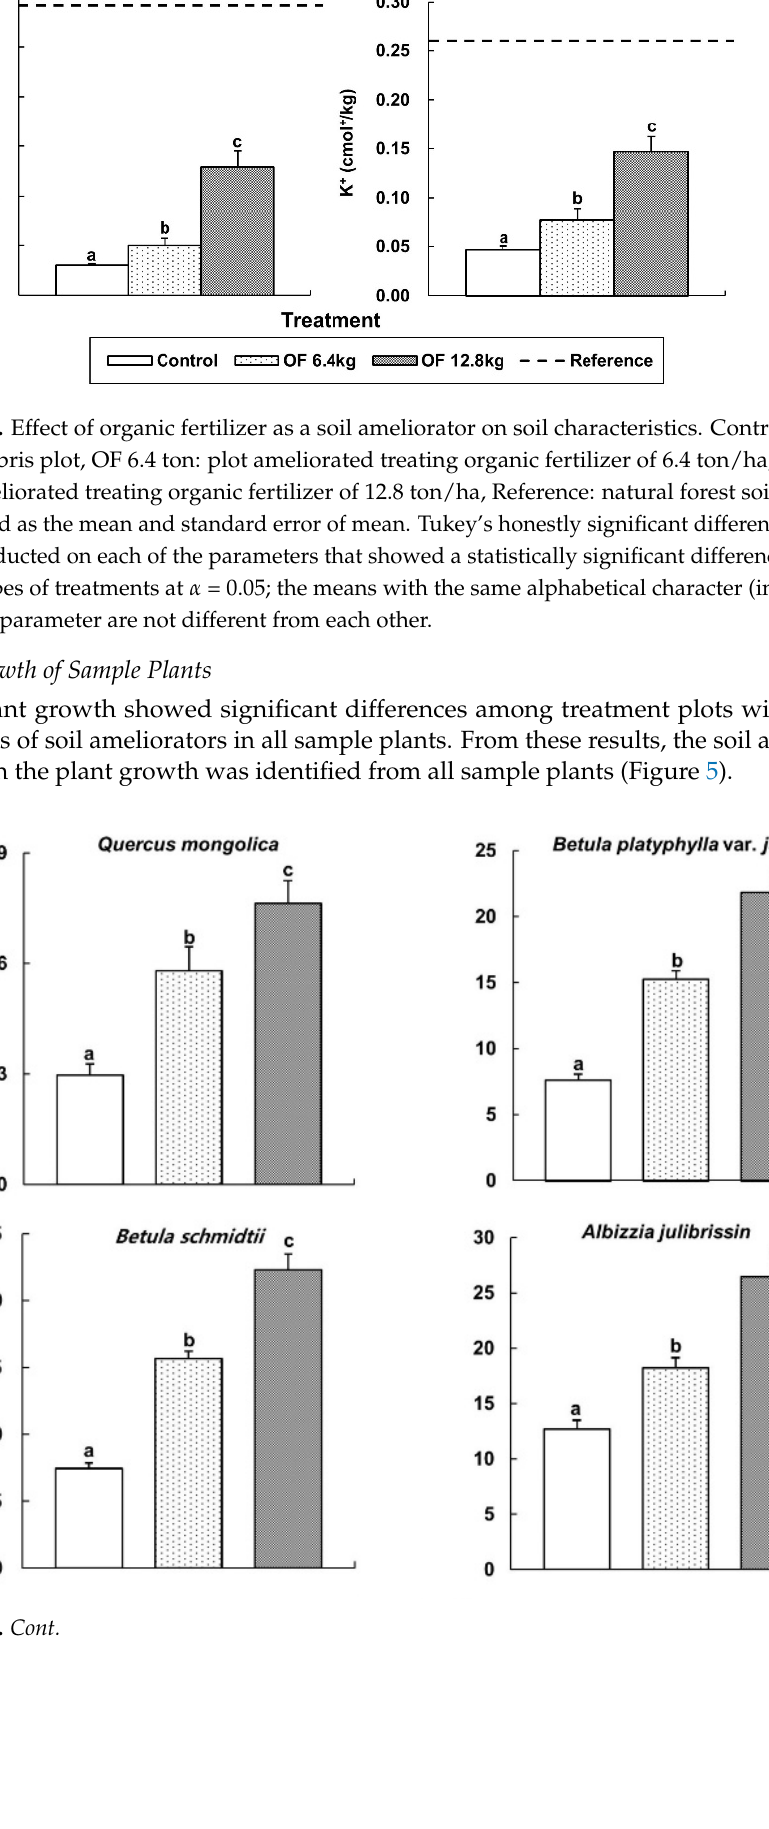
Figure 5. Height growth response of sample plants in control (fresh coal mine debris) and amelio- rated plots (OF 6.4 ton and OF 12.8 ton). Control: fresh coal mine debris plot, OF 6.4 ton: plot ame- liorated treating organic fertilizer of 6.4 ton/ha, OF 12.8 ton: plot ameliorated treating organic ferti- lizer of 12.8 ton/ha, Reference: natural forest soil. Each bar expresses the mean and standard error of the mean. Tukey’s honestly significant difference (HSD) test was conducted on each of the pa- rameters that showed a statistically significant difference among the three types of treatments at α = 0.05; the means with the same alphabetical character (in superscript) for each parameter are not different from each other. 3.5. Species Composition The restoration site located in the lowlands consisted of an ecologically restored site, two afforested sites by introducing Betula schmidtii and Robinia pseudoacacia , and non-re- stored sites, respectively. As a result of stand ordination, the non-restored sites were lo- cated far from the reference sites and the restored and afforested sites, showing a large difference in species composition (Figure 6). The restored sites were located closer to the reference sites than the sites afforested through the introduction of Robinia pseudoacacia , along with the sites afforested through the introduction of Betula schmidtii on Axis I. Mean- while, the restored sites were located closer to the reference sites than the sites afforested through the introduction of Betula schmidtii along with the sites afforested through the introduction of Robinia pseudoacacia on Axis II. Synthesizing the results, the restored sites tended to be located closer to the reference sites than the non-restored sites as well as the